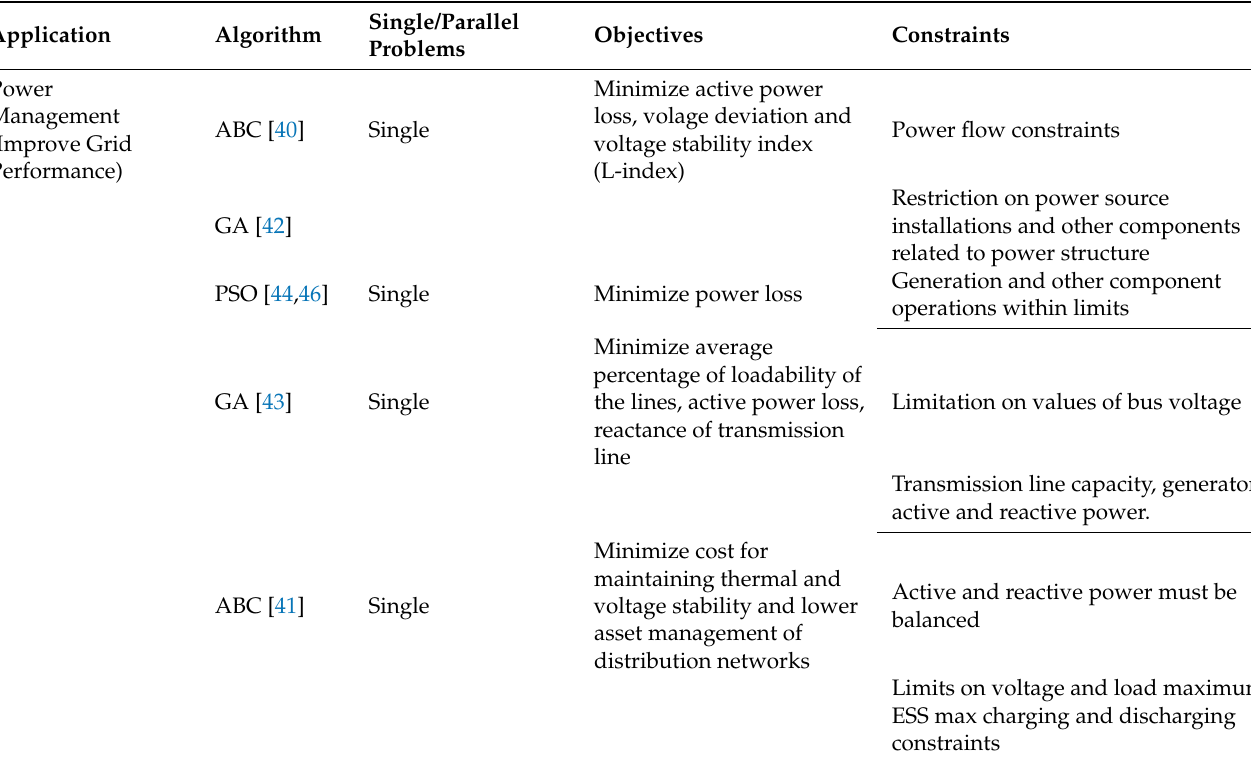
Table 5. Optimization in Smart